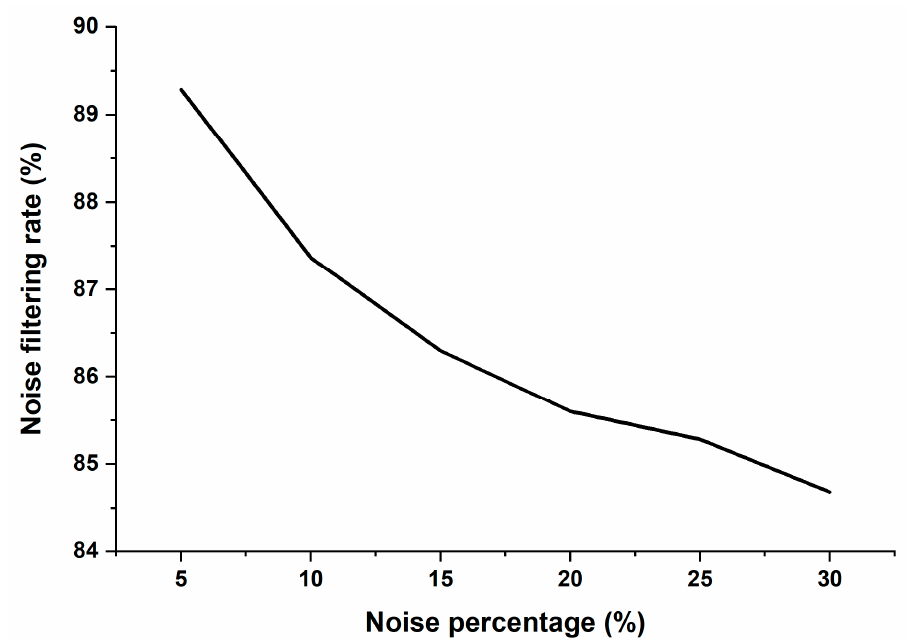
Figure 6. Analysis of noise filtering result by adding different percentages of noise.